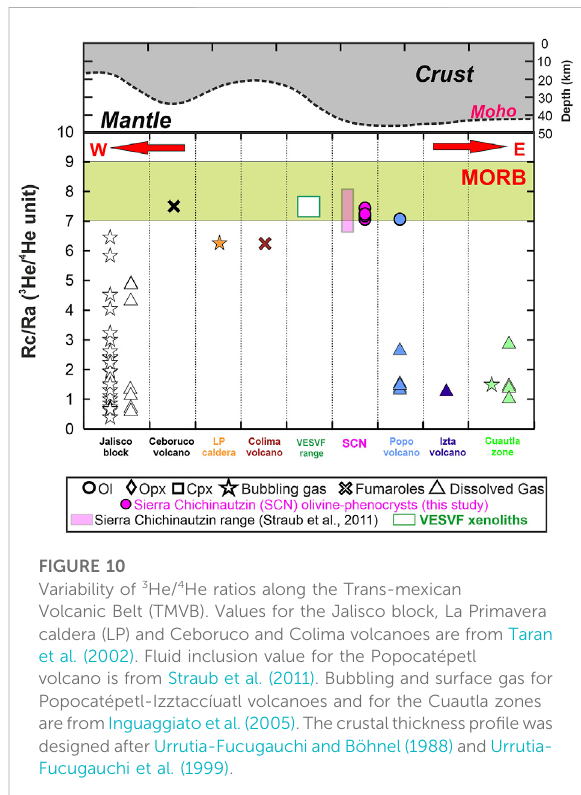
FIGURE 10 Variability of 3 He/ 4 He ratios along the Trans-mexican Volcanic Belt (TMVB). Values for the Jalisco block, La Primavera caldera (LP) and Ceboruco and Colima volcanoes are from Taran et al. (2002). Fluid inclusion value for the Popocatépetl volcano is from Straub et al. (2011). Bubbling and surface gas for Popocatépetl-Izztaccíuatl volcanoes and for the Cuautla zones arefromInguaggiatoetal.(2005).Thecrustalthicknesspro fi lewas designed after Urrutia-Fucugauchi and Böhnel (1988) and Urrutia- Fucugauchi et al.